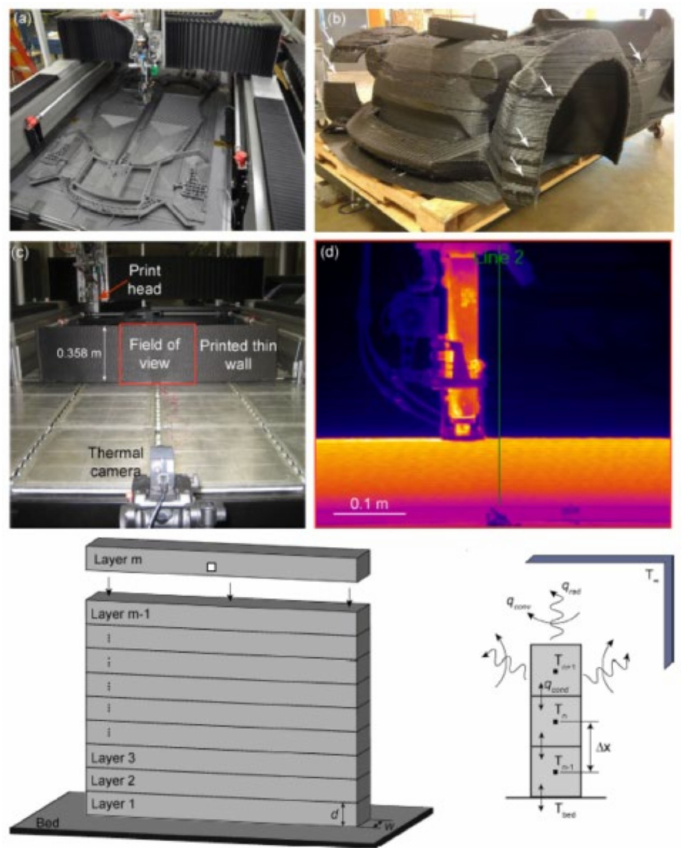
Figure 6. Representation of the BAAM system, experimental set-up, thermal image, and 1D thermal model schematic (reprinted with permission from [112]).